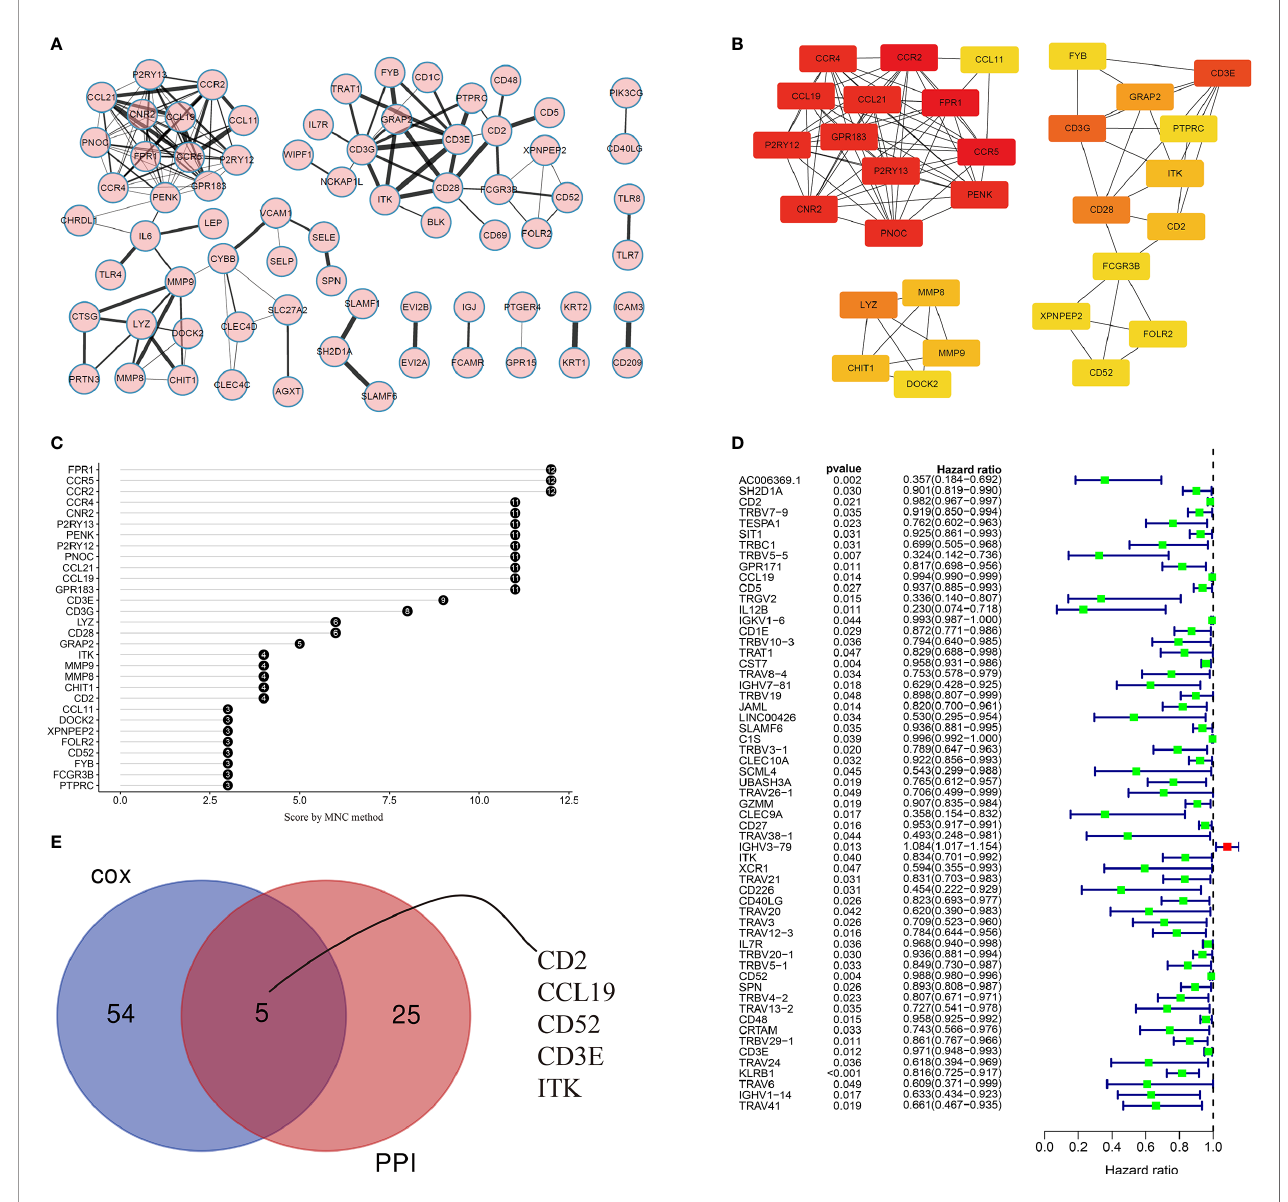
FIGURE 5 | Visualization of the PPI network and univariate Cox regression analyses. (A) PPI network based on STRING con fi dence score >0.9. Thicker edges between nodes indicate stronger combined scores. (B) Identi fi cation of hub genes in the PPI network using the MNC algorithm. Red nodes represent genes with high MNC scores, while yellow nodes represent genes with lower MNC scores. (C) Lollipop diagrams of MNC scores of the top 30 genes. (D) Forest plot of univariate Cox regression analyses, showing genes with p < 0.05. (E) Venn diagram of the intersection between the top 30 hub genes in the PPI network and the 59 signi fi cant genes in the Cox regression